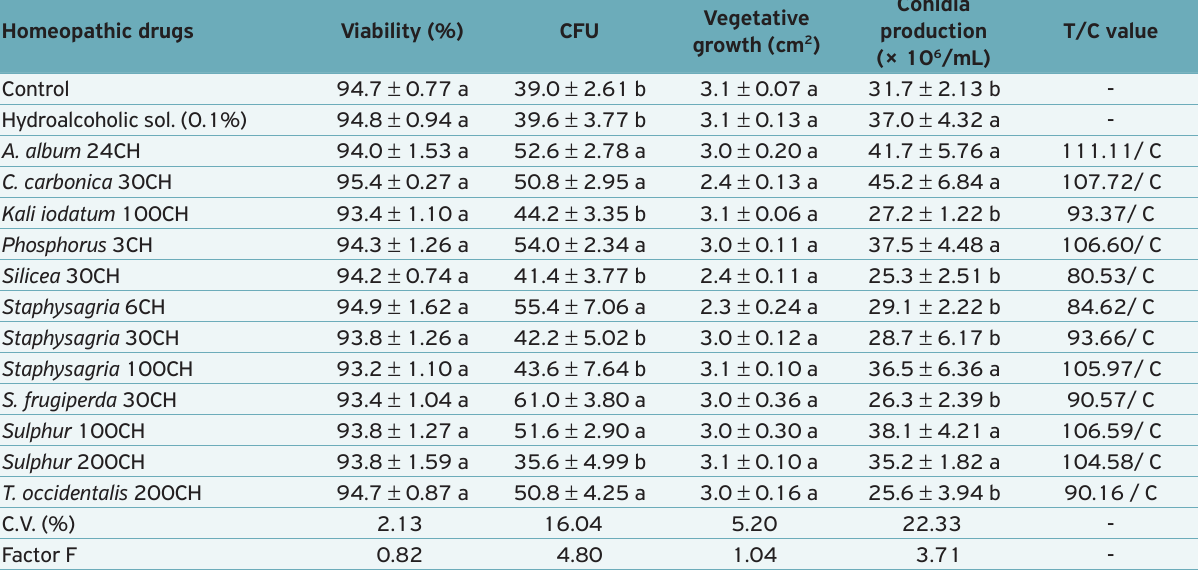
Table 3. Viability of conidia, colony forming units, vegetative growth, conidia production, “T” values and compatibility of Metarhizium